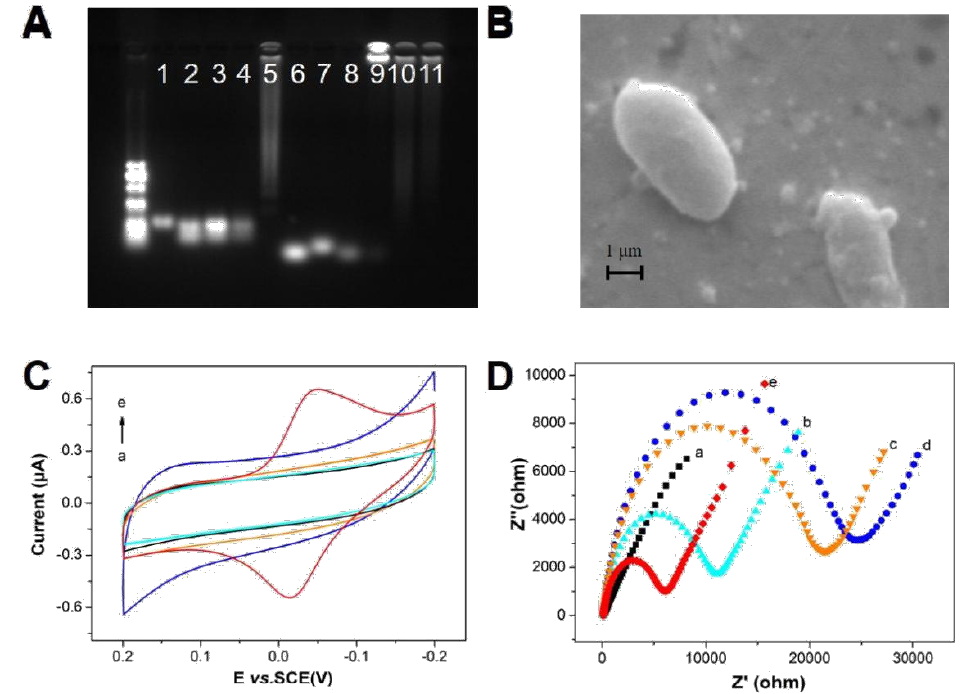
Figure 1. ( A ) Agarose gel electrophoresis image. Lane 1, 10 µ M Tetra − A; lane 2, 10 µ M Tetra − B; lane 3, 10 µ M Tetra − C; lane 4, 10 µ M Tetra − D; lane 5, DNA tetrahedron structure; lane 6, 10 µ M RCA template; lane 7, 10 µ M primer; lane 8, 10 µ M capture; lane 9, hemin/G − quadruplexes; lane 10, DNA tetrahedron structure + hemin/G − quadruplexes (lane 5 mixture with lane 9 for 2 h); lane 11, DNA probe + hemin/G-quadruplexes + P. Aeruginosa (lane 5, lane 9 and lane 10 mixture for 2 h). ( B ) SEM image of PANI/ P. Aeruginosa modified gold electrode. ( C ) Cyclic voltammograms and ( D ) Nyquist plots of (a) bare gold electrode, (b) DNA probe, (c) hemin/G − quadruplexes/DNA probe, (d) P. aeruginosa /hemin/G − quadruplexes/DNA probe, (e) PANI.